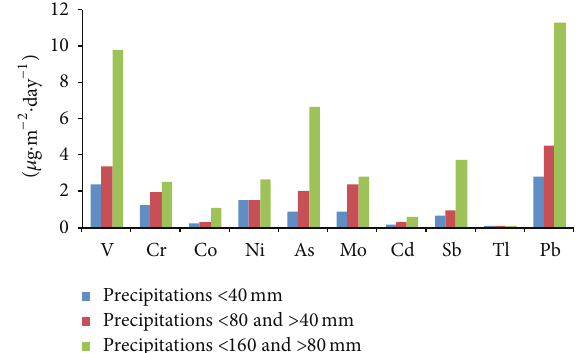
Total PAH Total PAH R.C. Figure 8: Fluxes of total PAH and total PAH R.C. and precipitations in D4 from August 2005 to March 2010.